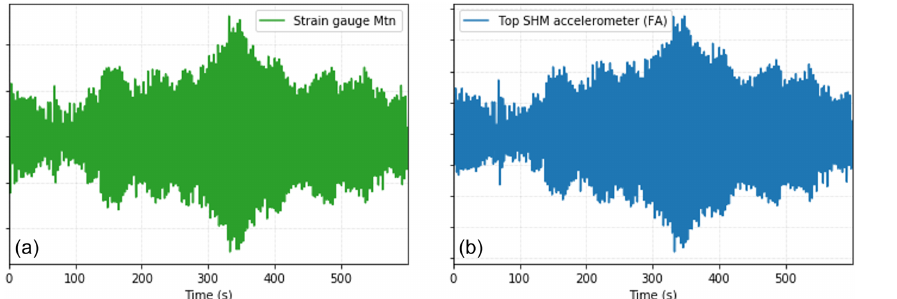
Figure 1. (a) Fore–aft bending moment ( M tn , Nm) signal, measured by the strain gauges during a standstill occurrence of 600s. (b) Top tower SHM accelerometer fore–aft displacement signal (m) for the same period as in panel (a)